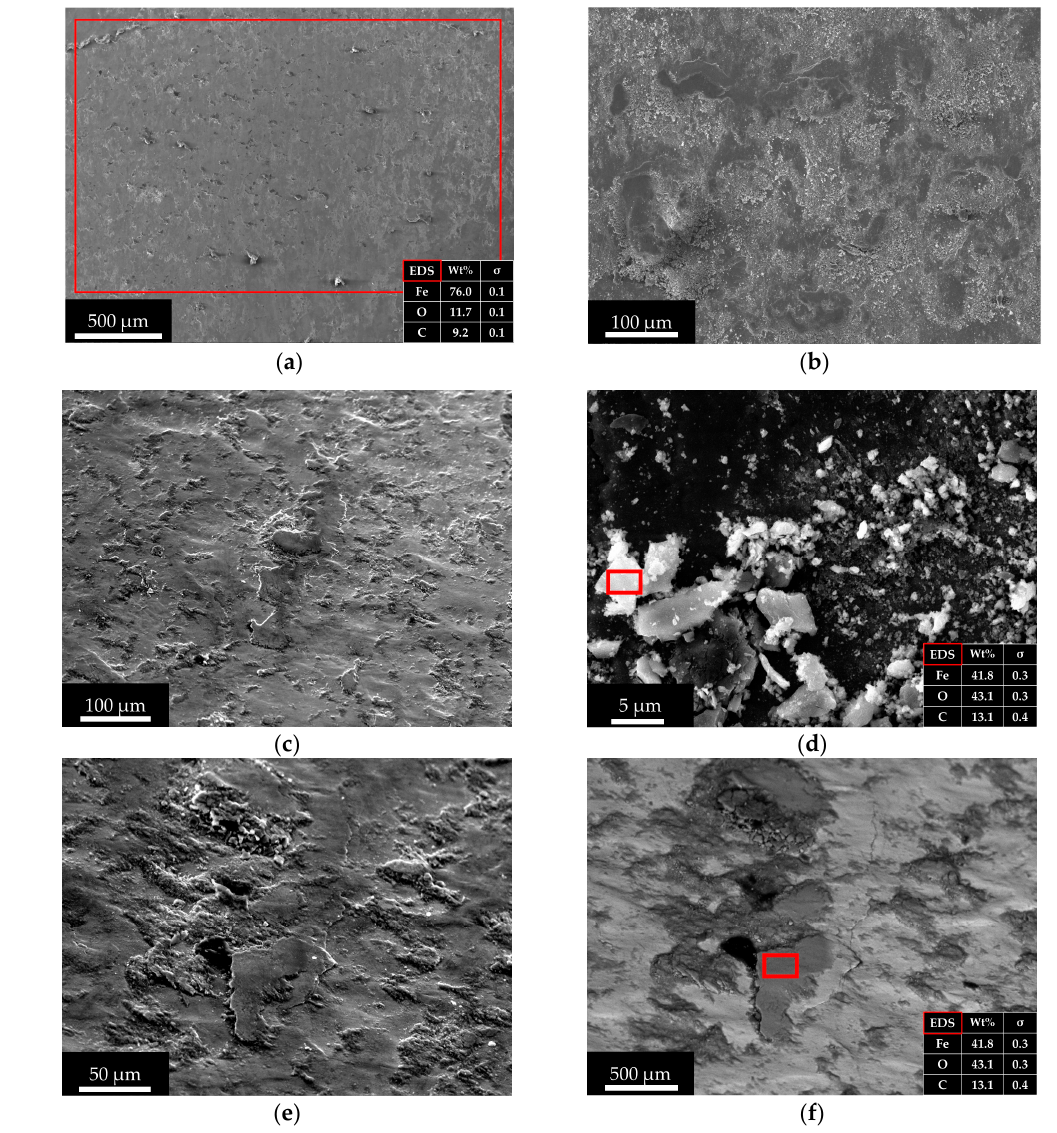
Figure 7. ( a ), ( b ), ( c ), ( d ) and ( e ) secondary scanning electron microscopy (SE-SEM) micrographs and ( f ) Backscattered scanning electron microscopy (BS-SEM) micrograph of the worn surfaces and wear debris after rolling/sliding wear of the sample transformed to bainite at 220 °C after austenitization at 900 °C for 30 min Red squares represent the EBS analysis